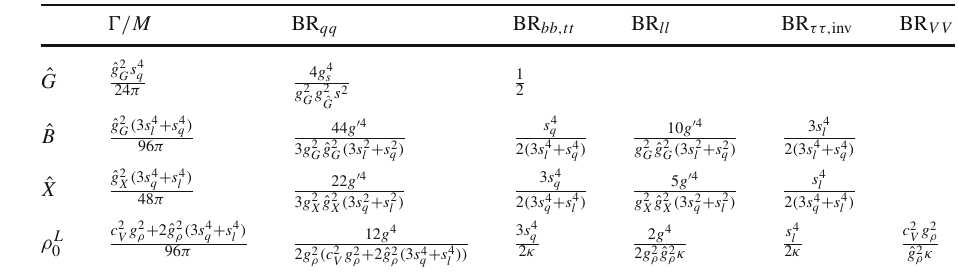
Table 3 Relevant quantities for the phenomenology of singly-produced neutral resonances in the model. All the formulas are given at leading order in the elementary couplings. In the last